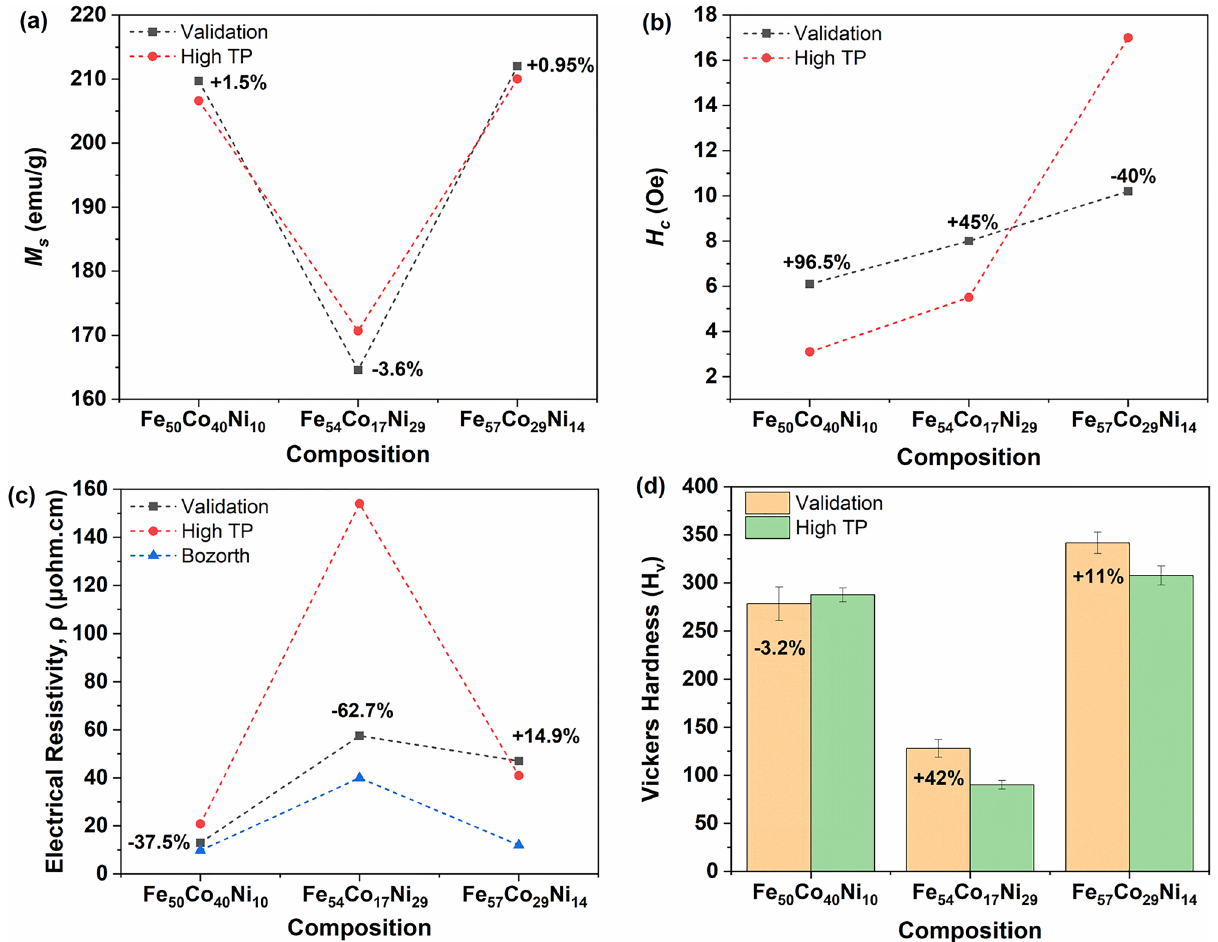
Figure 9. Validation results for ( a ) saturation magnetization, M s , ( b ) coercivity, H c , ( c ) electrical resistivity, ρ, and ( d ) Vickers hardness, H v